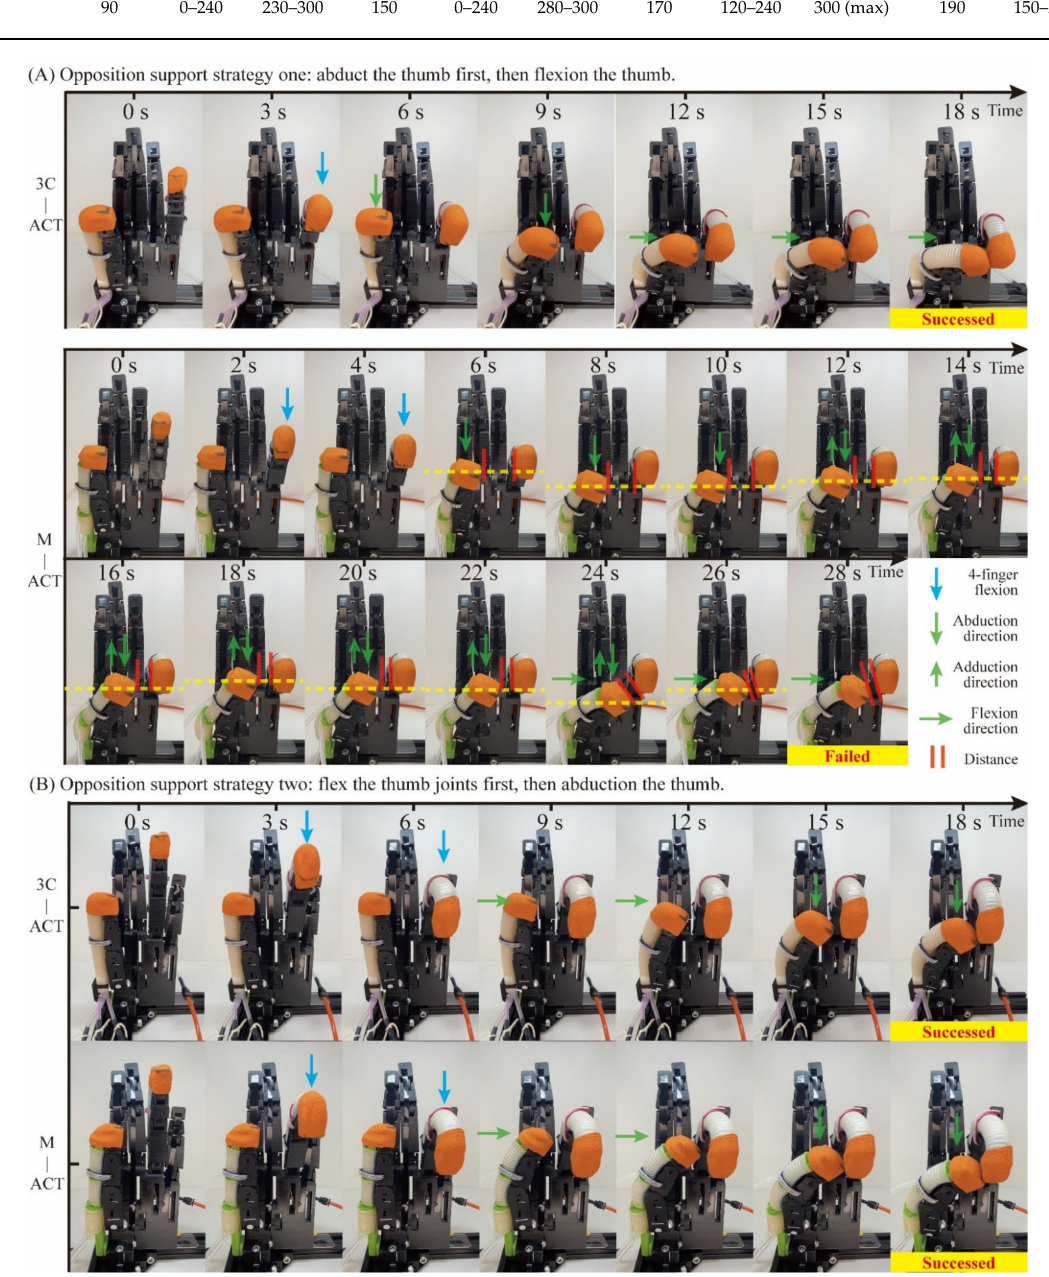
Figure A1. Two strategies for thumb